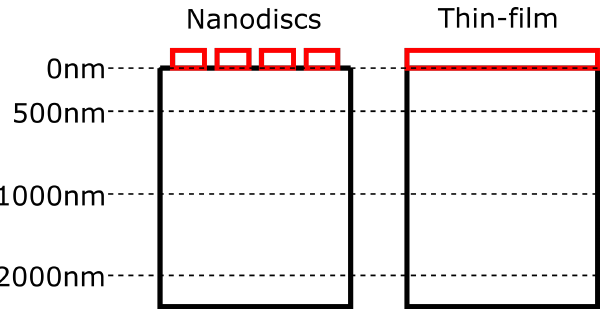
Figure 6. Absorption simulation setup for nanodisk and thin-film structures. The investigated nanodisk arrays and InP thin film are depicted in red on top of a bulk Si substrate (black). Absorption of all structures is measured in the Si substrate at depths of 0, 500, 1000 and 2000nm.